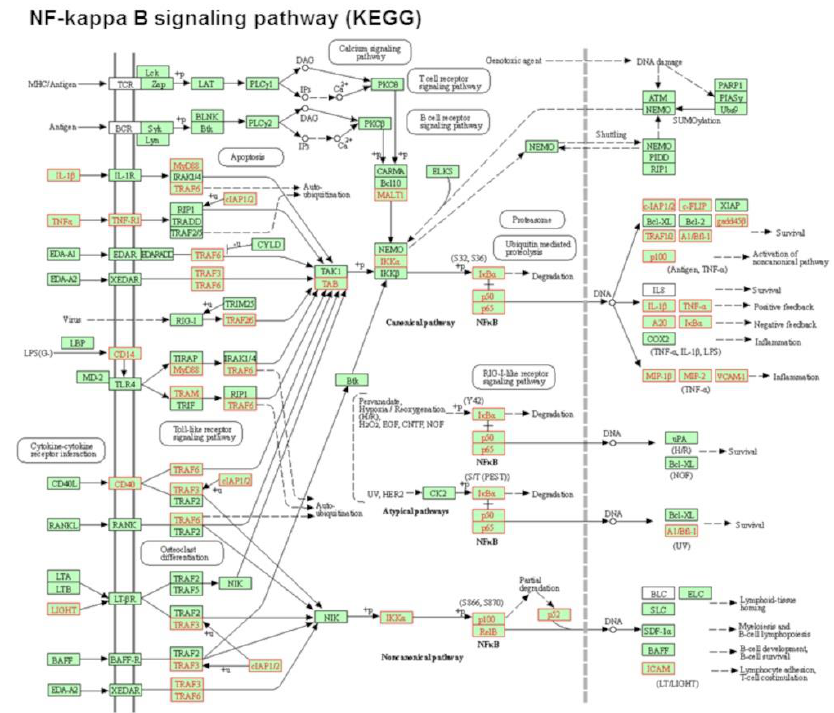
Figure 3. POPC liposomes induce the activation of the NF-kappa B signaling pathway. Analysis of the most significantly activated KEGG pathway by POPC liposome treatment corresponding to the NF-kappa B signaling pathway. Genes that are up-regulated in this pathway by POPC liposome exposure vs. PBS treatment are marked in red (29 genes). Statistical Pathway Impact Analysis (SPIA) shows a False Discovery Rate with adjusted global p -values (pGFdr) of 2.81 × 10 −09 for this pathway.